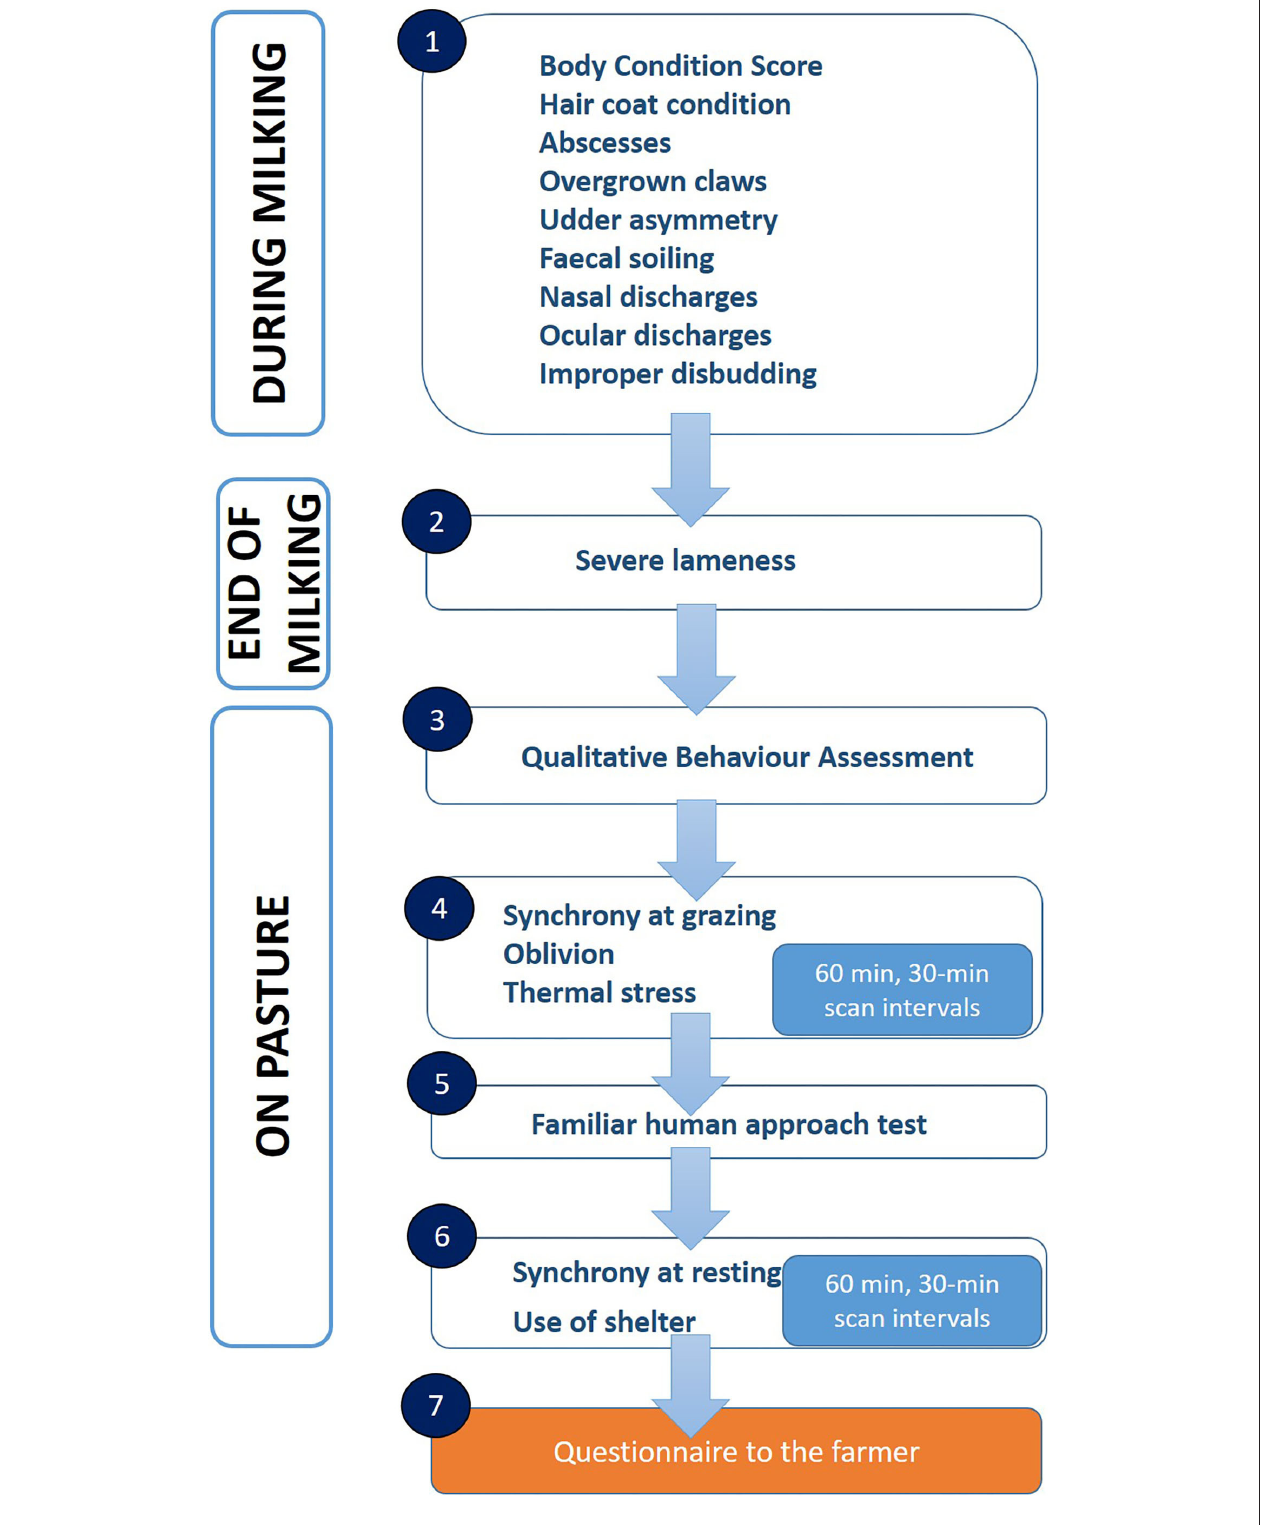
FIGURE 1 | Flowchart of data